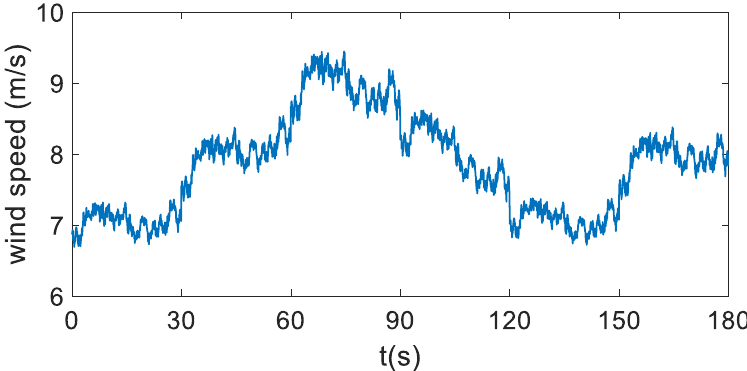
Figure 5. The wind speed in low wind speed region with slight turbulence.